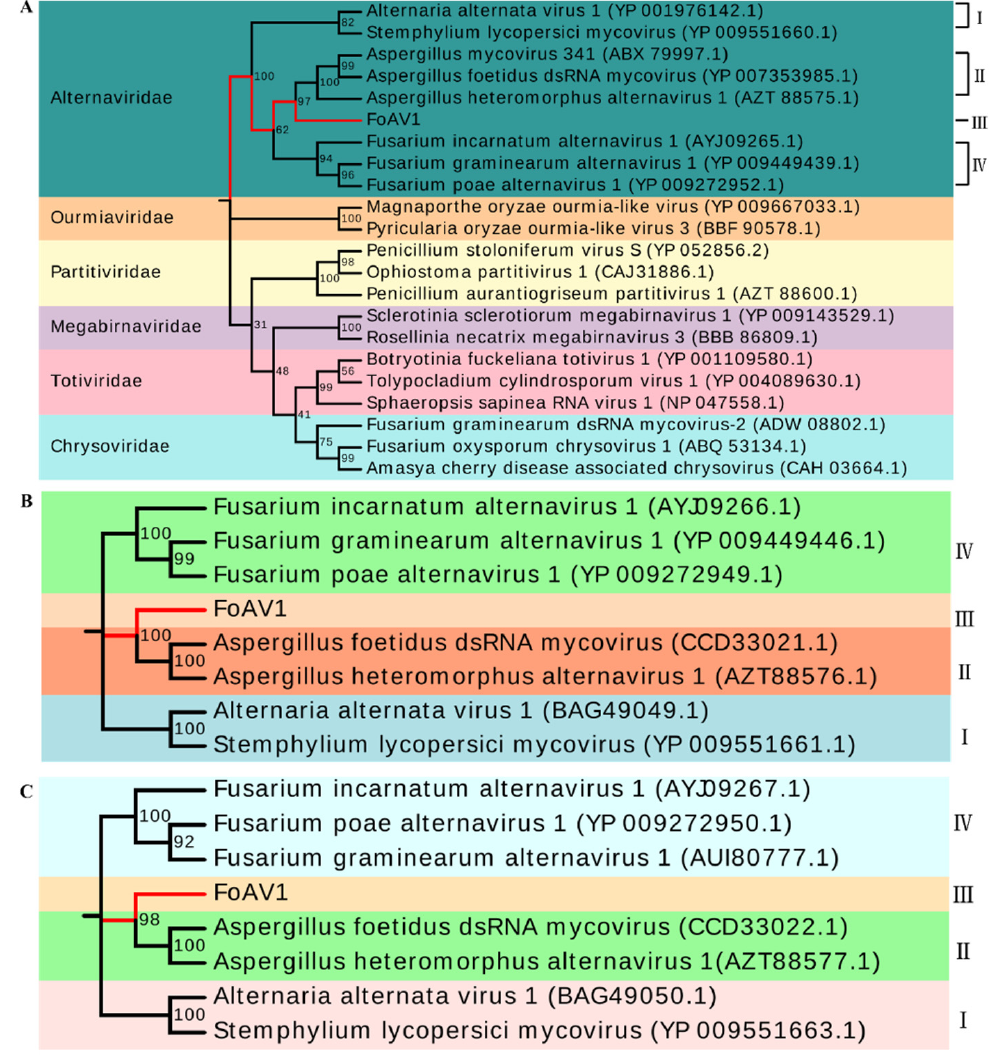
Figure 4. ( A ) Maximum likelihood phylogenetic trees based on the FoAV1 RdRp (ORF1) sequence, “Alternaviridae” family members and other related viruses. ( B ) Maximum likelihood phylogenetic tree based on the FoAV1 ORF2 sequence and other “Alternaviridae” family members. ( C ) Maximum likelihood phylogenetic tree based on the FoAV1 ORF3 sequence and other “Alternaviridae” family members. All phylogenetic analyses generated using MEGA7 with 1000 bootstrap replicates. Ⅰ to Ⅳ represent clades of the proposed “Alternaviridae” family. Different colors represent clustering in different families or clades. I, II, III and IV represent different clades of “Alternaviridae” family,